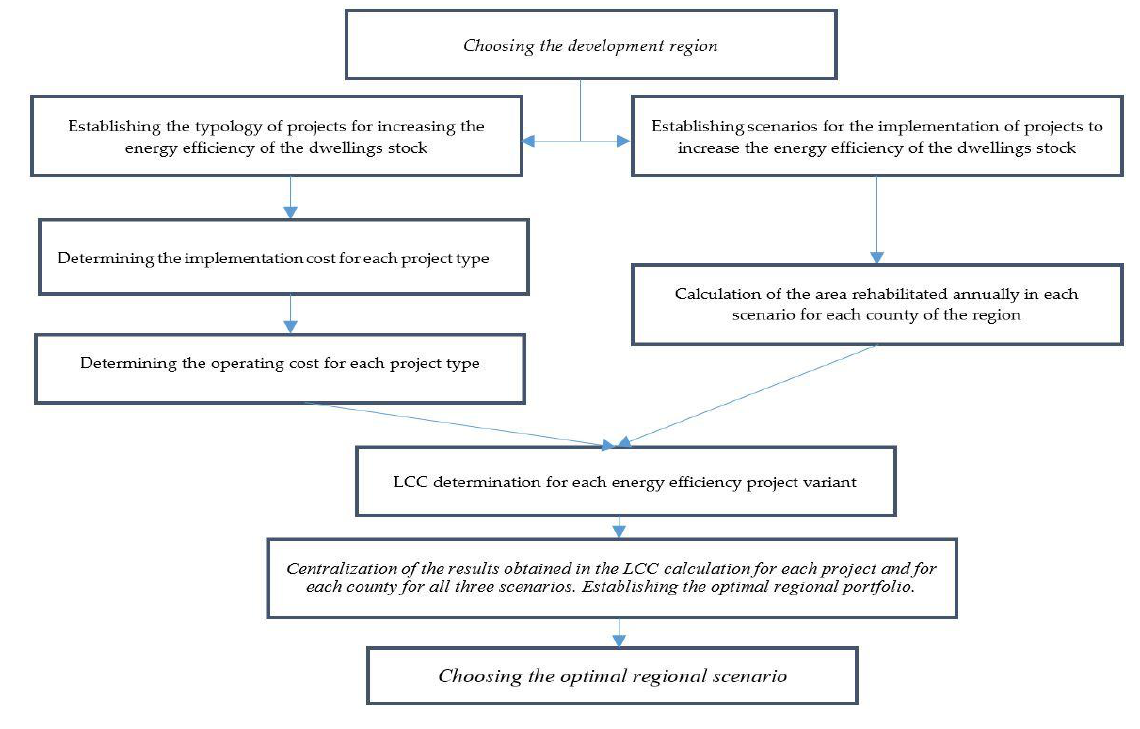
Figure 2. Research methodology.